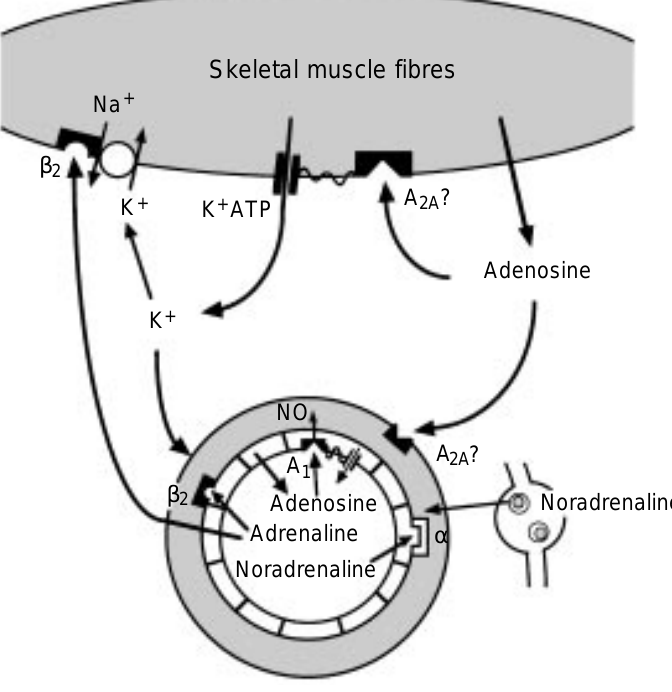
Figure 6 - Schematic diagram showing some of the factors that influence the arterioles of skeletal muscle during systemic hy- poxia and the cellular mechanisms by which they may act. Nora- drenaline released from sympathetic nerve fibres and circulating in the blood stream exerts a constrictor influence via a